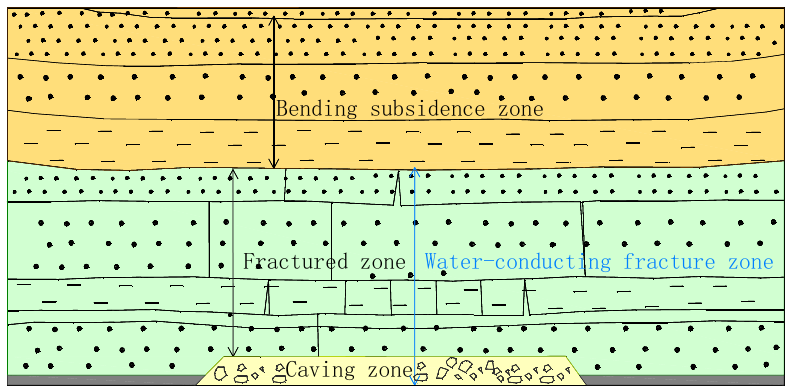
Figure 4. Division diagram of the “upper three zones” of the roof of the mining coal seam: bending subsidence zone, rock layers bend and subside, but there is no obvious macro fracture caused by mining activities in this zone; fractured zone, the macro fractures caused by mining activities are numerous, and the structure of rock layers has been damaged in this zone; caving zone, the roof layers of a coal seam break up into rock blocks and fall into goaf; water-conducting fracture zone, ground water can flow in fractures caused by mining activities without restriction in this zone.